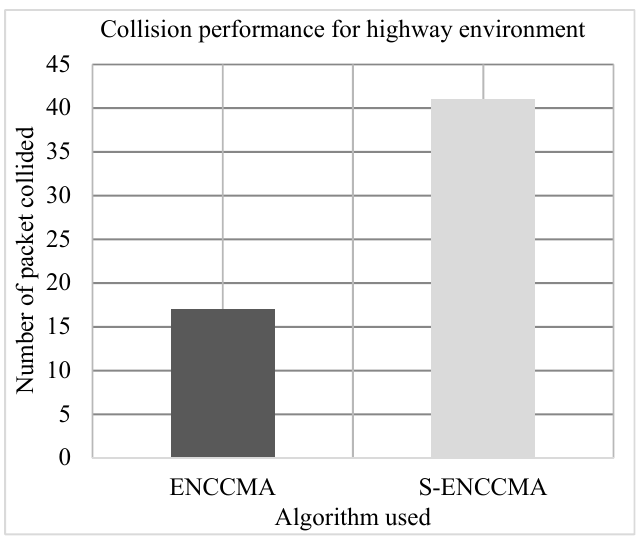
Figure 10. Collision performance achieved for a highway environment.